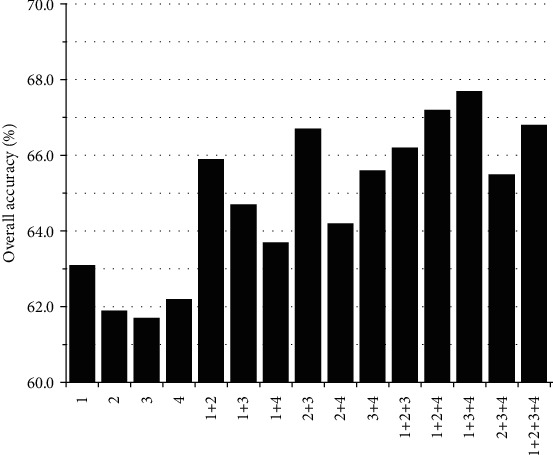
The combination scheme of chemical shifts. The number 1 denotes 1Hα, 2 denotes 1HN, 3 denotes 15N, and 4 denotes13Cα.